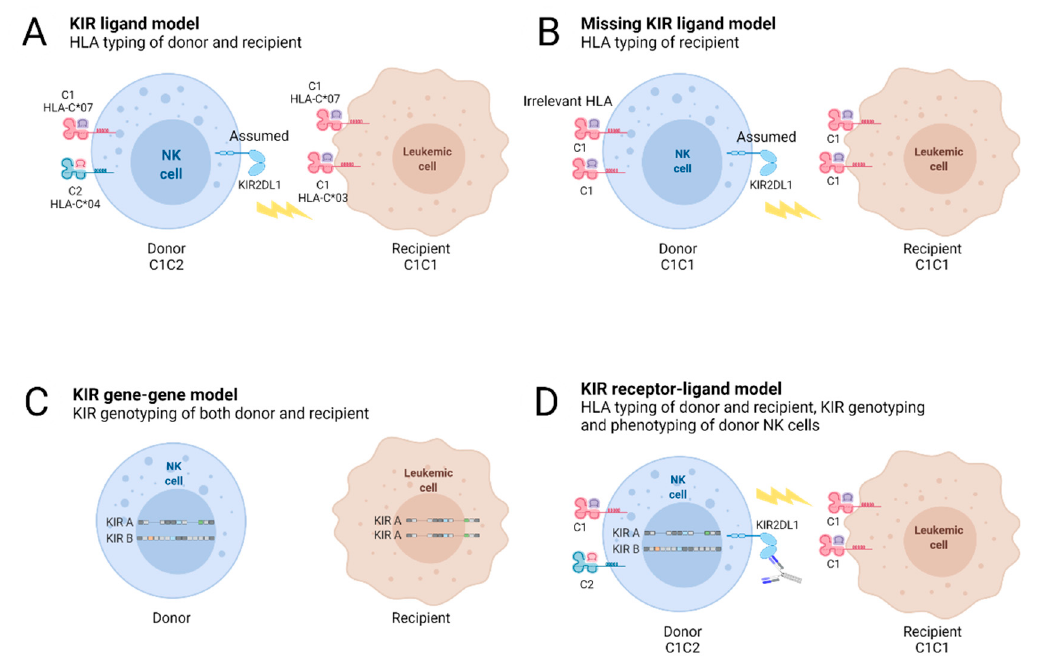
Figure 4. Genetic KIR/KIR ligand models defined to predict potential KIR + NK cell alloreactivity (adapted from Symons et al. [134]). Genotyping of HLA class I and/or KIR genes permits the establishment of different KIR/KIR ligand